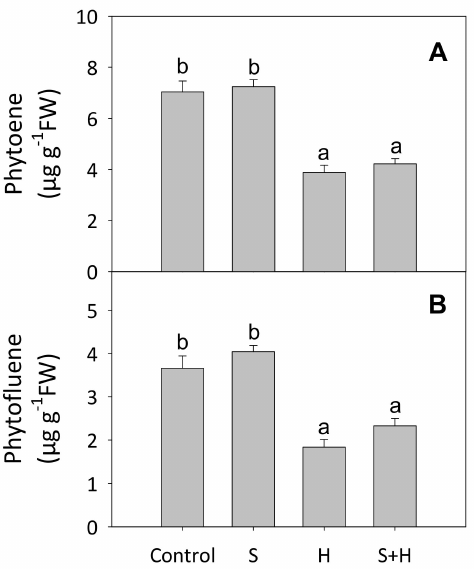
Figure 6. Concentration of phytoene ( A ) and phytofluene ( B ) ( µ g g − 1 fresh weight) in tomato fruits under control (C), saline (S) and heat conditions (H) or the combination of salinity and heat (S + H). Values are means ± SE ( n = 6). Different letters indicate significant differences between means according to Duncan’s test at the 5% level.